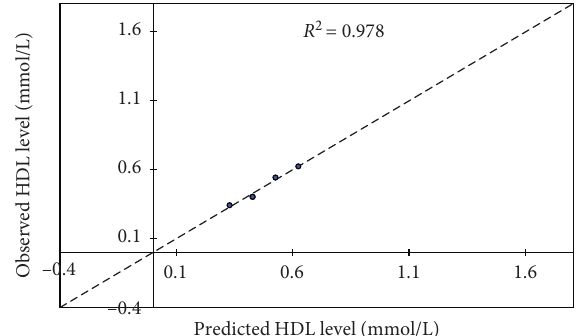
Figure 8: Predicted HDL level against observed one as a lipid profile parameter, where y � HDL levels and x � Costus afer con- centrations served as input values.